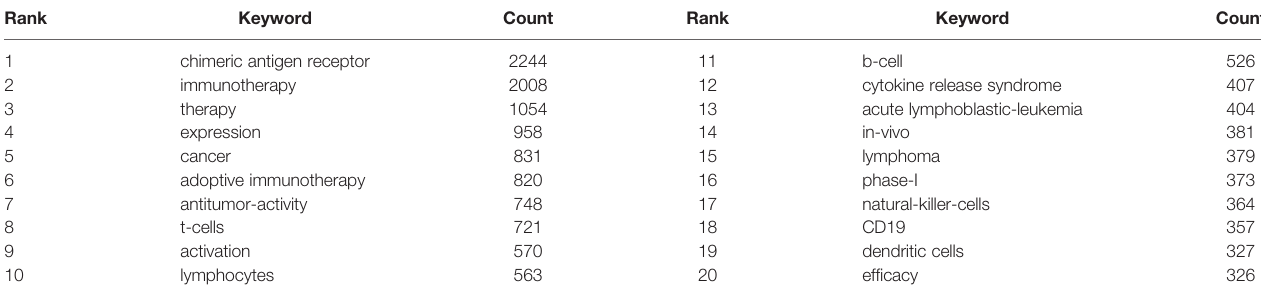
TABLE 4 | The top 20 keywords related to CAR-T